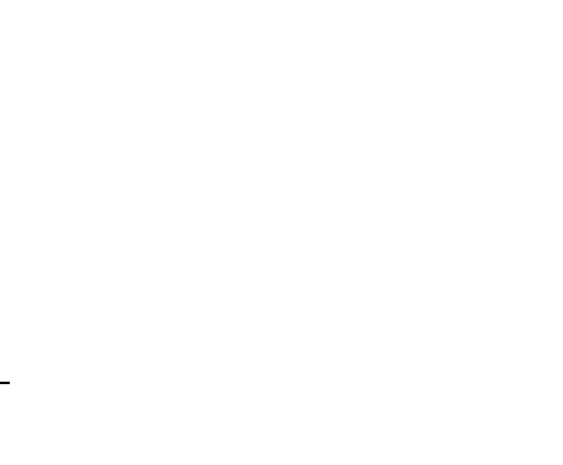
8 of 14 Figure 5. Dry weight of A. pelegrina seeds at different maturity stages. FR1: Fruit stage 1; FR2: Fruit stage 2; FR3: Fruit stage 3; FR4: Fruit stage 4; FR5: Fruit stage 5. * Values with different letters in the graph indicate statistically significant differences, Tukey ( p ≤ 0.05). The bars represent the standard error. 3.3. Seed Testing 3.3.1. In Vitro Establishment Figure 6 shows the percentage of germinated seeds 30 days after in vitro establish- ment. The significant differences ( p < 0.05) revealed by the test indicate that successful germination greatly depends on seed pretreatment by mechanical scarification. In con-